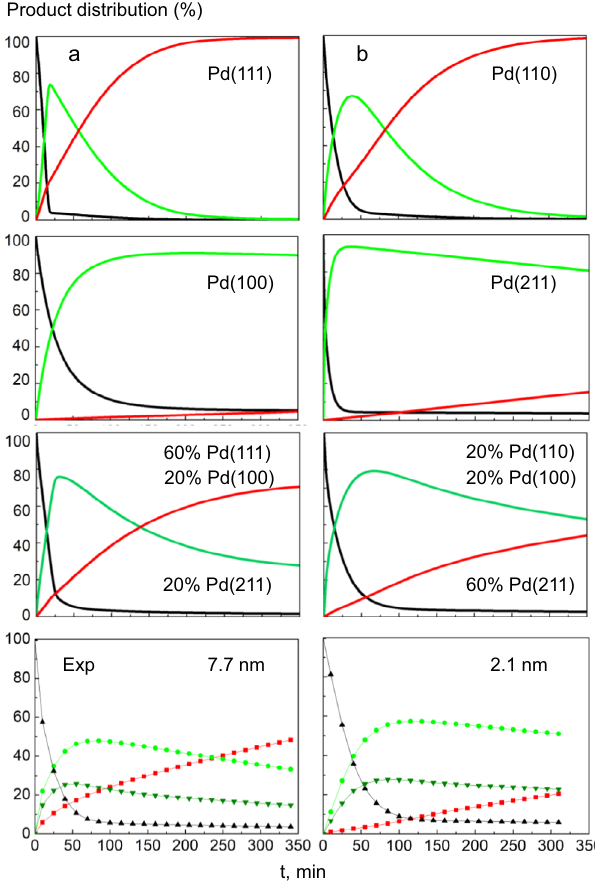
Fig. 6 Simulated product distribution of 1-butene isomerization and hydrogenation as a function of the reaction time at 373 K. For a Pd(111), Pd(100), the mixture 60% Pd(111)/20% Pd(100)/20% Pd(211), and, at the bottom, the corresponding experimental results for average Pd NPs of 7.7 nm. b Analogous reactions simulated for Pd(110), Pd(211), the mixture 60% Pd(211)/20%Pd(110)/20% Pd(100), and the corresponding experimental results for average Pd NPs of 2.1 nm. Color coding: black — 1- butene, red — n-butane, light green — trans -2-butene, dark green — cis -2-